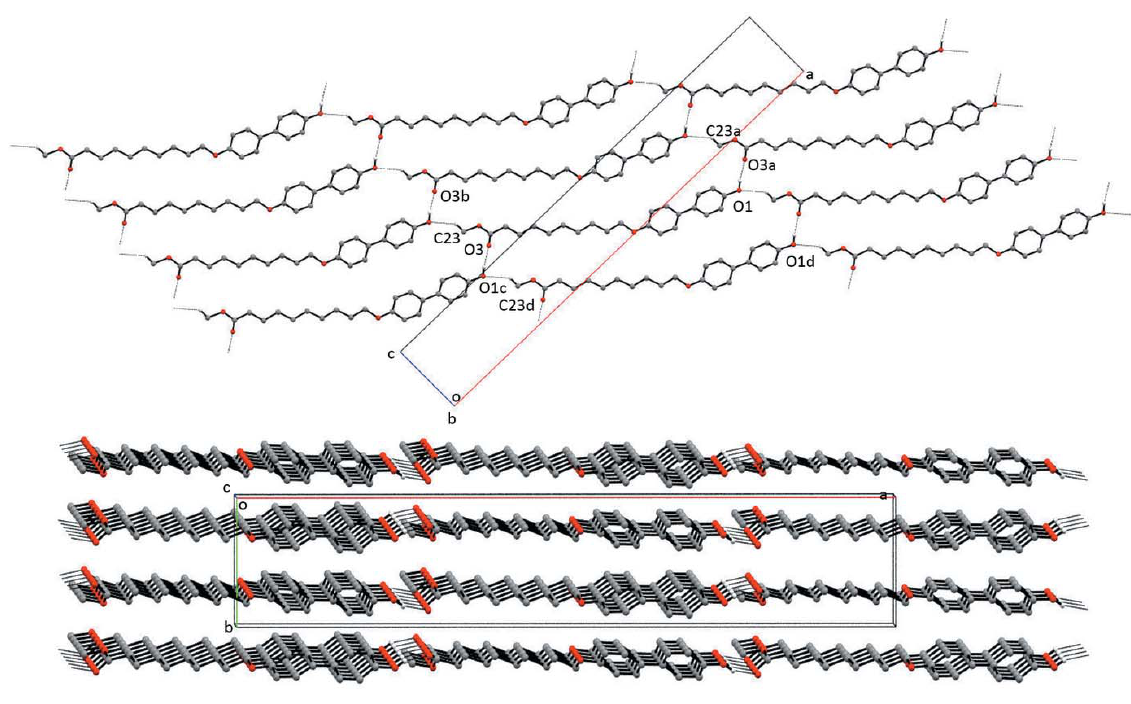
Figure 2 Two views of the packing in MBO10Me showing the layers parallel to (010). Only the H atoms involved in the O—H (cid:2)(cid:2)(cid:2) O and C—H (cid:2)(cid:2)(cid:2) O hydrogen bonds are shown. Symmetry codes: ( a ) x + 1